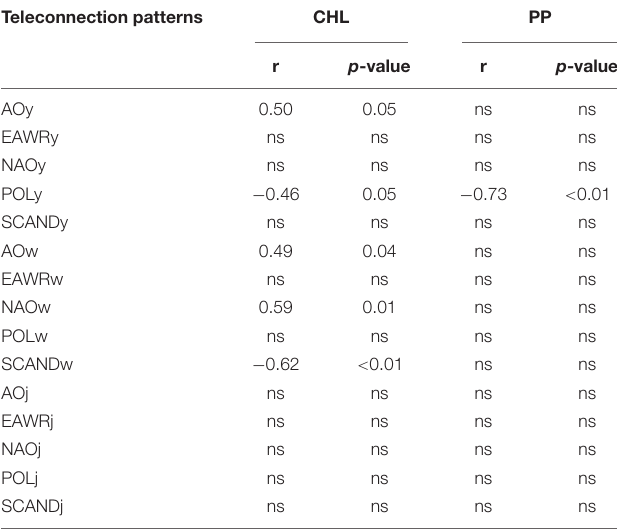
TABLE 2 | Pearson’s correlation coefficients (r) between chlorophyll a concentration (CHL) and plankton primary production (PP) in the Neva Estuary